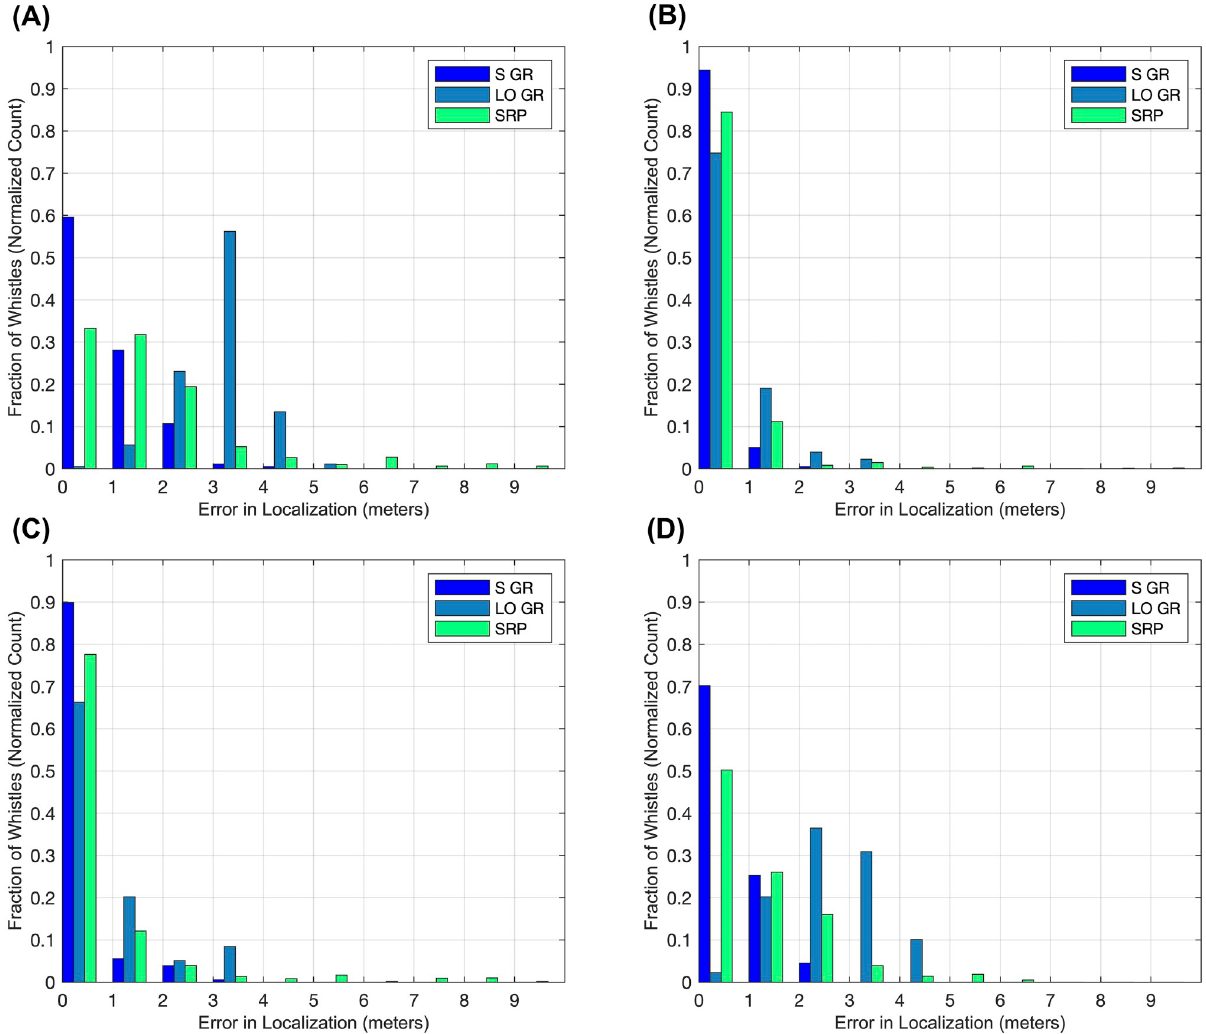
Fig 6. Multi bar graphs displaying histogram data for the test set source coordinate prediction error sets (3 methods x 4 axes). For the Standard Gaussian Regression (S GR), Leave-Out Gaussian Regression (LO GR), and SRP methods, test snippet tonal localization error (absolute deviation) is displayed (A) for the Euclidean (straight-line) direction, (B) for the X-axis, (C) for the Y-axis, and (D) for the